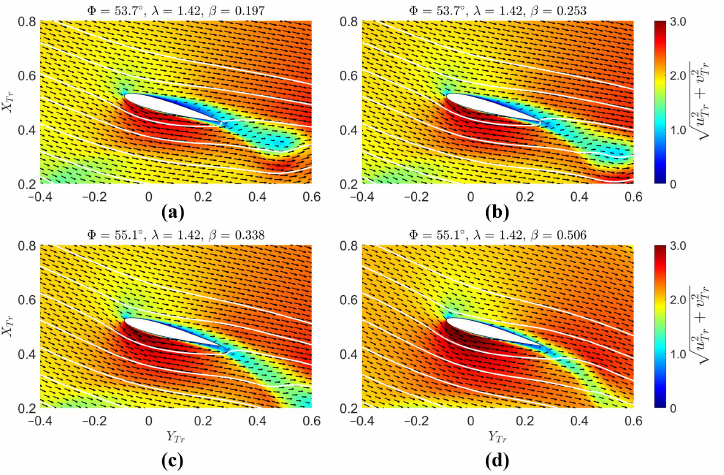
Figure 13. The velocity fields in the blade reference frame before it reached the maximum torque of 4 blockage ratios: 19.7% ( a ), 25.3% ( b ), 33.8% ( c ), and 50.6% ( d ). On each figure, the lower surface is the turbine inner side and the upper surface is the turbine outer